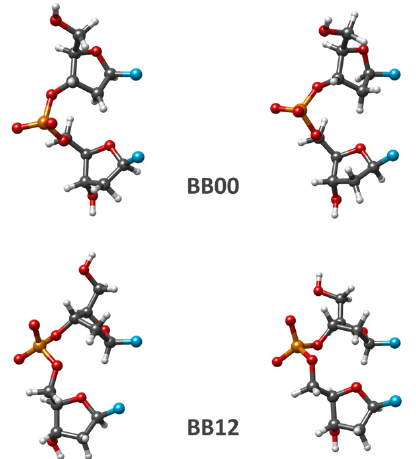
Figure 3. Experimental ( left ) and PBE optimized ( right ) SPB conformations of two NtC classes having torsion angles corresponding to the energy minima of separate SPB fragments. Geometry optimization introduces a minor change in the mutual position of glycoside bonds. The base nitrogens were replaced by hydrogens in the computations.